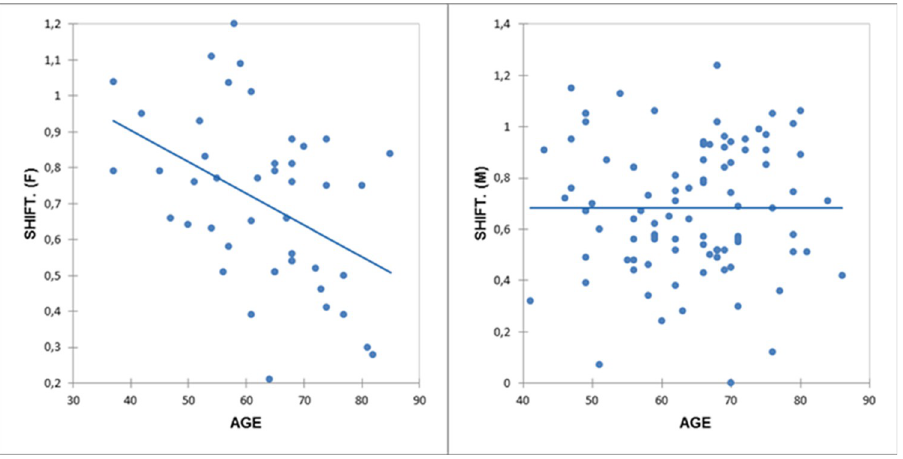
Fig 4. Correlations between age and shifting index in the sample stratified for gender. The shifting index is significant for females alone (r = − 0.44, p = 0.003). F , Females; M , Males; SHIFT , shifting index.